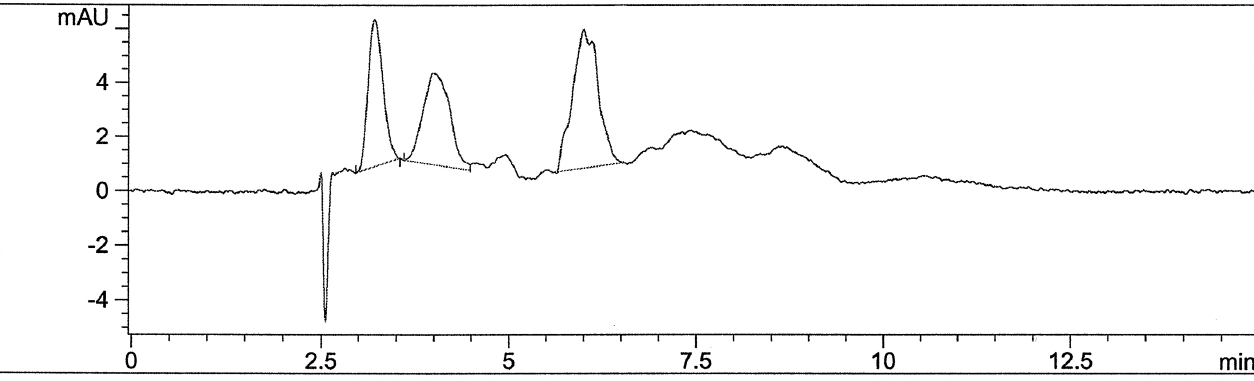
FIGURE 3 - Chromatogram of acid hydrolysis sample after 24 hours of incubation (refer to Chromatographic Conditions